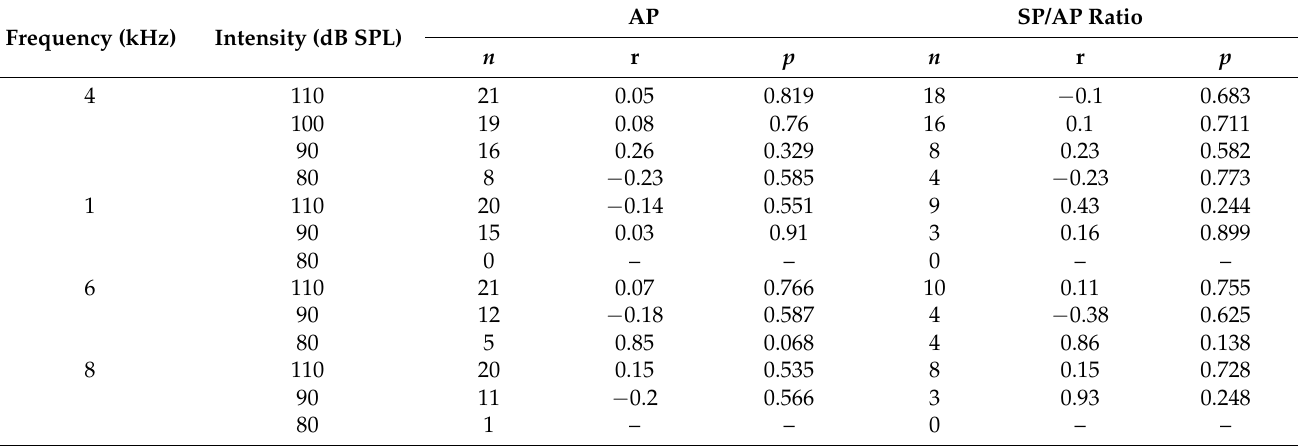
Table 7. Correlation analysis of THI scores with AP amplitudes and SP/AP ratios in the tinnitus